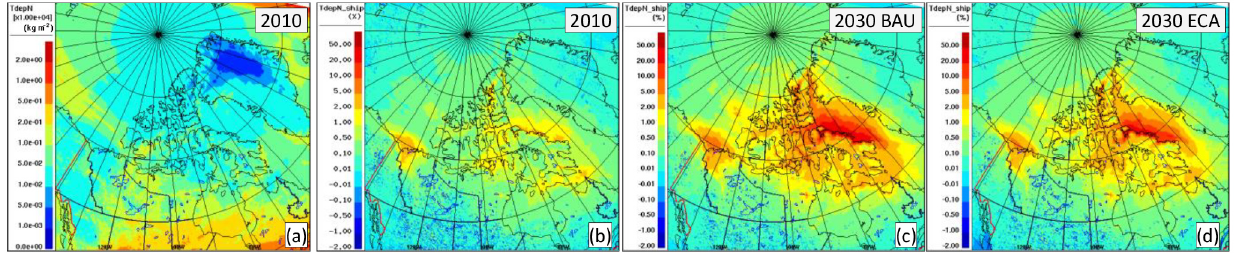
Figure 16. (a) Total nitrogen deposition over the July–August–September period (accumulated) for the base case (2010); (b) Arctic shipping contribution at current (2010) level; (c) the same as in (b) for the 2030 BAU scenario; (d) the same as in (b) for the 2030 ECA scenario.